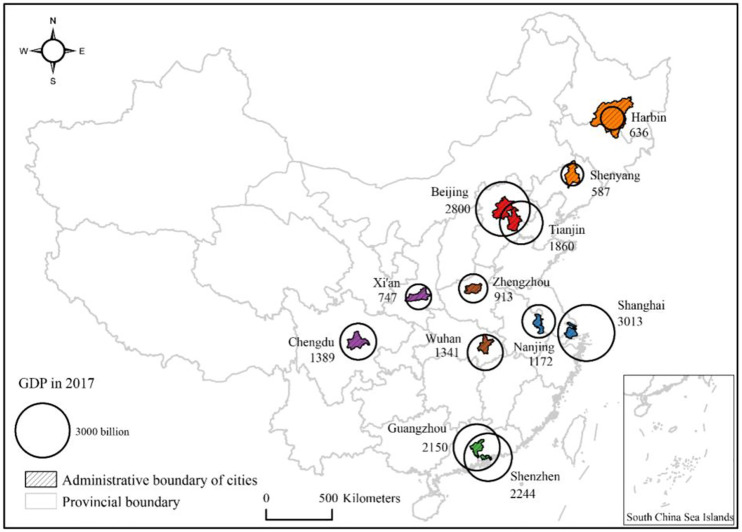
The spatial distribution of twelve megacities of China.All of them are the most representative cities in typical regions of China, including North China (Beijing, Tianjin) drawn in red, Northeast China drawn in orange (Harbin, Shenyang), Central China drawn in brown (Zhengzhou, Wuhan), West China drawn in purple (Xi’an, Chengdu), East China drawn in blue (Shanghai, Nanjing), South China drawn in green (Shenzhen, Guangzhou).